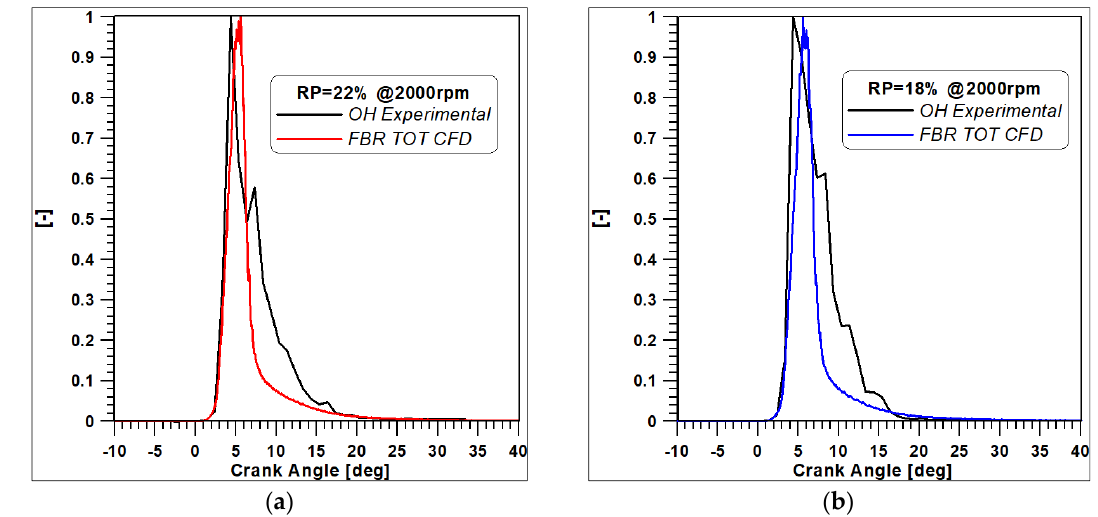
Figure 23. In-cylinder pressure curve in ( a ) RP = 22% and ( b ) RP = 18% cases @ 2000 rpm.